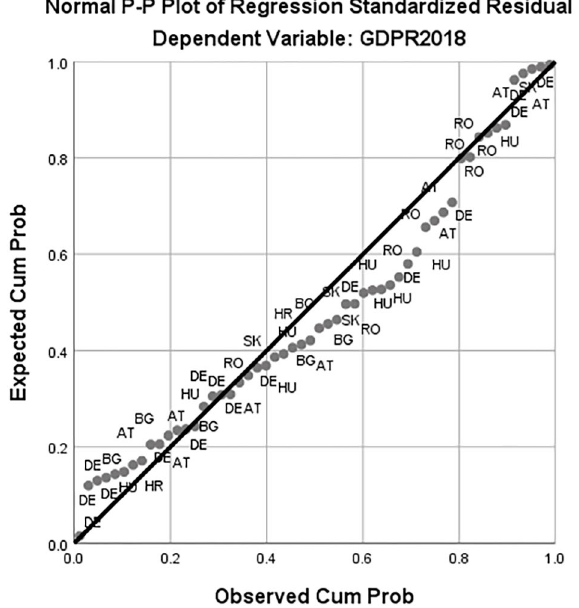
Figure 7. P-P Plot for sustainable development of EUSDR in 2018 Table 10. ANOVA test of the model for 2018 Mode Sum of Squares df Mean Square F Sig. Regression 101441.068 20288.214 47.747 0.000 b